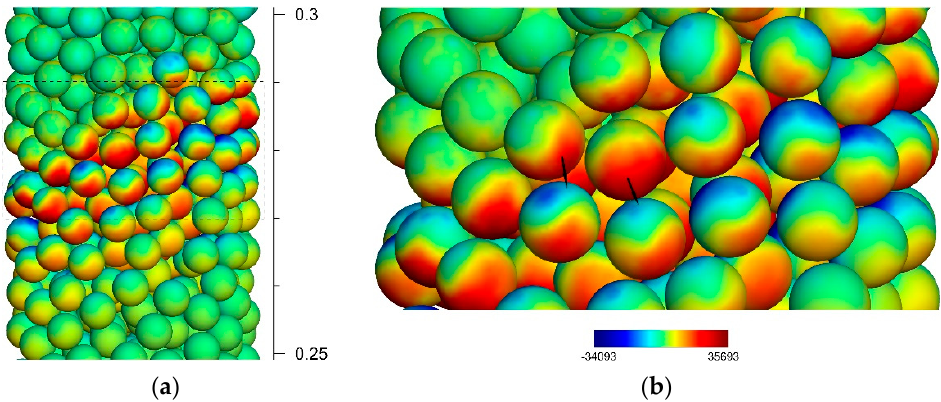
Figure 6. Radiation heat flux near the flame front for ϕ = 0.15, u g = 0.43 m/s at t = 373 s. ( a ) Radiation heat flux near the flame front/W/m 2 . ( b ) Radiation heat flux at enlarged view/W/m 2.